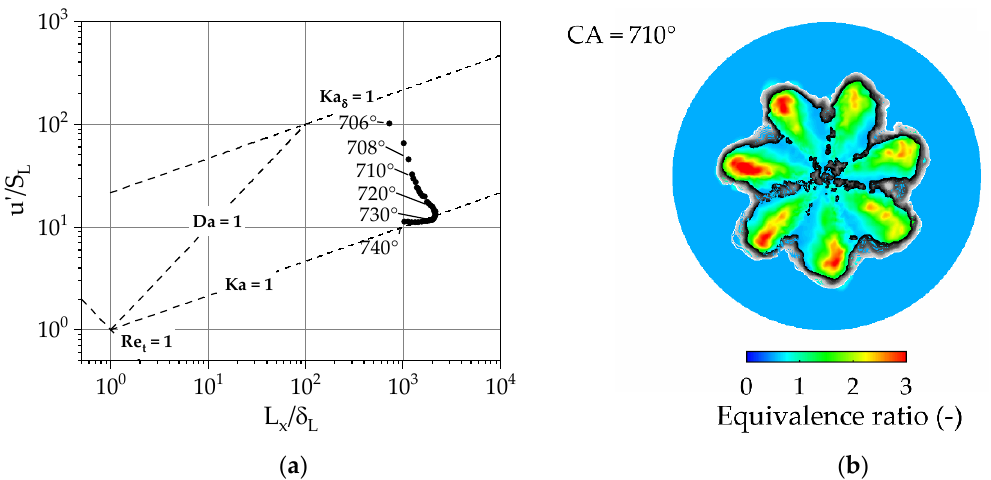
Figure 13. ( a ) Turbulent combustion regimes of the ensemble-averaged LES results plotted in the Borghi–Peters diagram for different crank angles. ( b ) Conical surface through the spray plumes depicting the equivalence ratio and the area in front of the flame by isolines of the RPV.